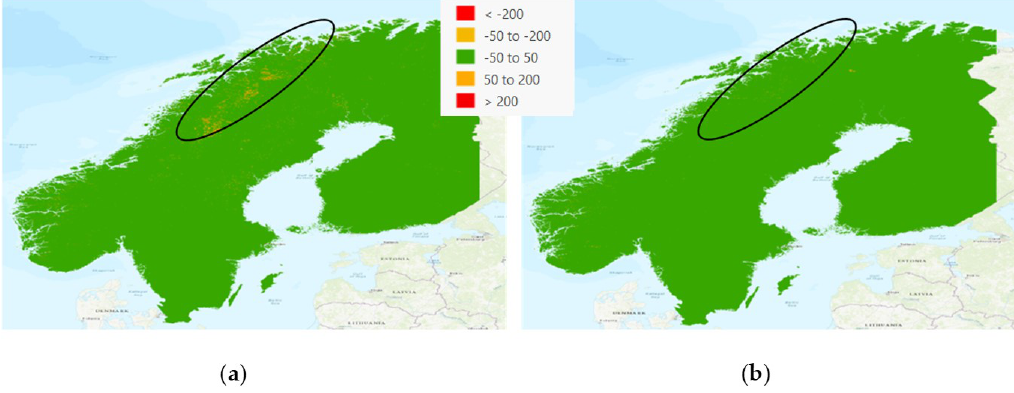
Figure 14. Di ff erences from WorldDEM layer using Collection-1 DEM ( a ) and the Collection-2 DEM ( b ). Area of largest improvement circled in black.